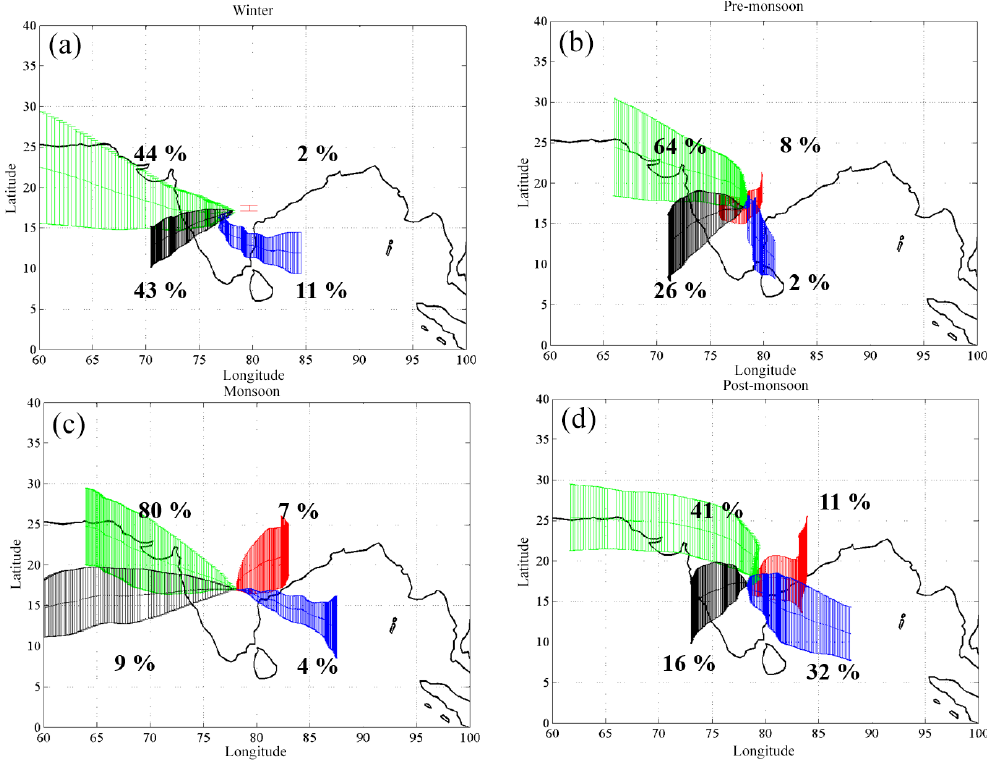
Figure 11. (a–d) Long-range circulation of air mass trajectories ending over Shadnagar at 3km during winter, pre-monsoon, monsoon, and